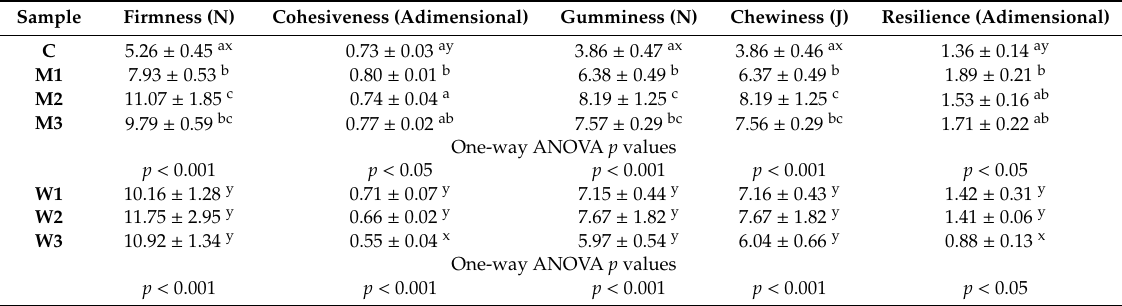
Table 4. Texture parameters of bread with di ff erent water replacement